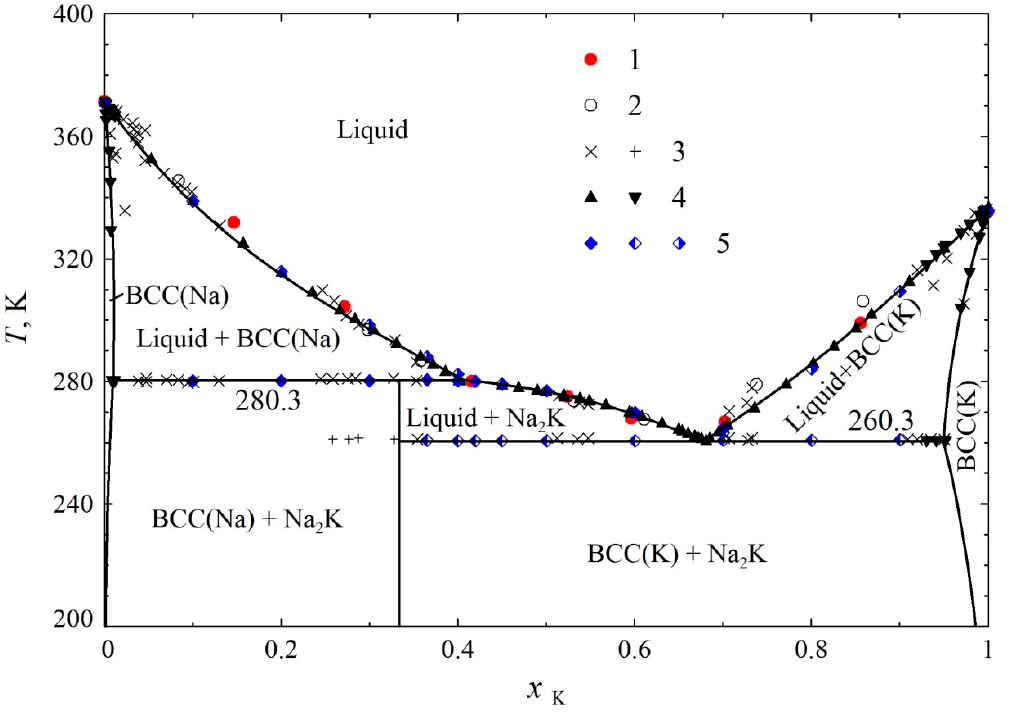
Figure 5. Phase diagram of the Na-K system. Lines are the result of calculation. Experimental data: 1—data from [16], 2—data from [17] according to [16], 3—data from [18], 4—data from [19], and 5—data from [20].